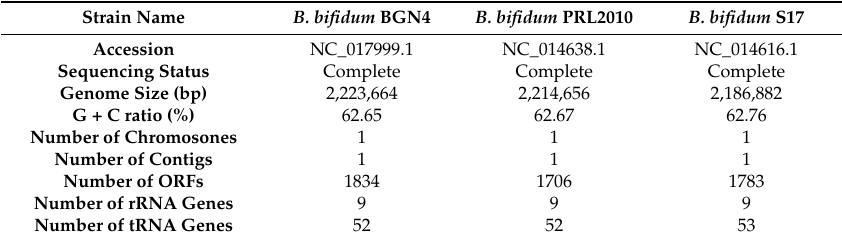
Table 2. Publicly available genome datasets of three different B. bifidum